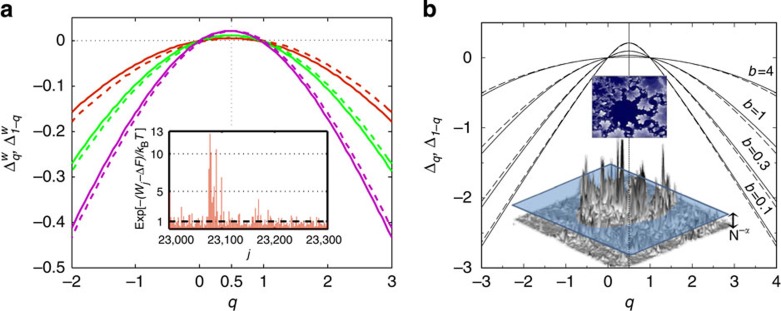
Comparison of  for dissipated work and multifractal critical exponents Δq.(a) The measured function  in equation (7) at drive frequencies f=1 (red), 2 (green) and 4 Hz (violet) and temperature T=214 mK. (Inset) A plot of the exponent of the dissipative work  versus the drive realization number j at a drive frequency f=1 Hz and temperature T=214 mK. In most of the drives the exponent is smaller than 1, which corresponds to W>ΔF, as the second law requires for averages. However, there are rare events seen as high spikes when ΔF−W>kBT. (b) Multifractal exponents Δq for the same model and parameters as in Fig. 1b (adapted with permission from ref. 21. Copyrighted by the American Physical Society). In both a and b small difference between Δq (solid lines) and Δ1 − q (dashed lines) violating the symmetry (equation (8)) is due to experimental (in a) or numerical (in b) errors. (Bottom inset) A plot of a typical amplitude  of the critical wavefunction in a two-dimensional lattice with N sites cut at a certain level  (adapted with permission from ref. 39. Copyrighted by the American Physical Society). (Top inset) The map of the region in space where  is a fractal of the Haussdorf dimension dh(α)=2f(α)<2. Multifractality implies a dependence of dh on α, or on the cutoff level N−α (adapted with permission from ref. 40. Copyrighted by the American Physical Society).